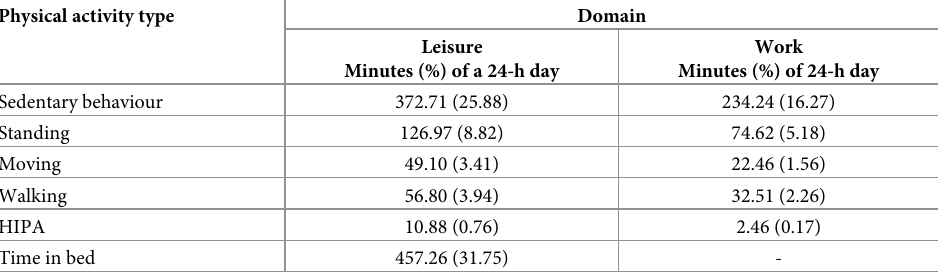
HIPA, high-intensity physical activity (sum of climbing stairs, running, cycling and